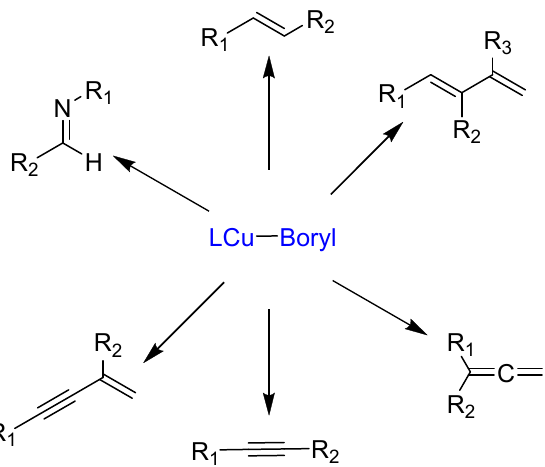
Figure 2. Commonly used substrates for Cu-boryl promoted reactions.